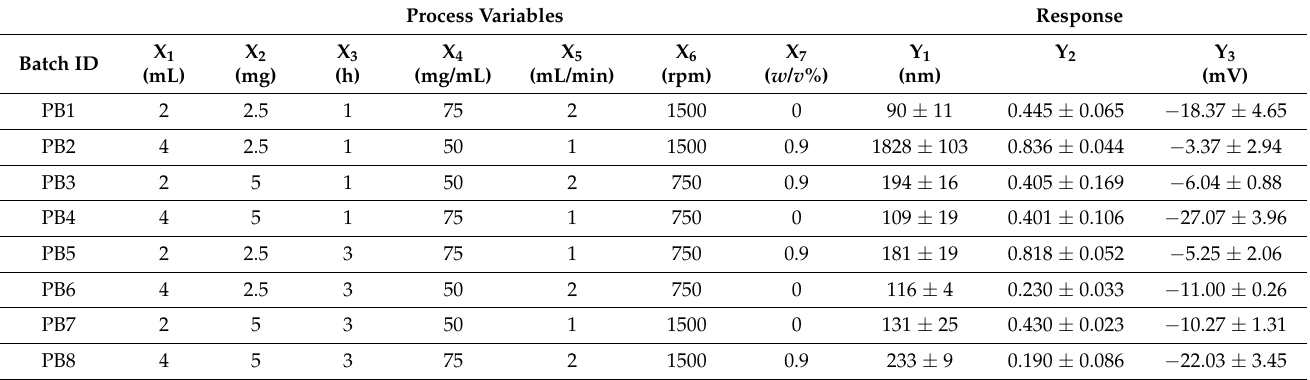
Table 4. Plackett–Burman screening design of experiments and their results: X 1 : Amount of EtOH (mL), X 2 : Amount of cross linker (EDC) (mg), X 3 : Incubation time (h), X 4 : Concentration of HSA (mg/mL), X 5 : Ethanol flow rate (mL/min), X 6 : Stirring speed (rpm), X 7 : Concentration of NaCl ( w / v %), Y 1 : Z-average (nm), Y 2 : PdI, and Y 3 : zeta potential (mV). Data are presented as mean ± SD, ( n = 3).